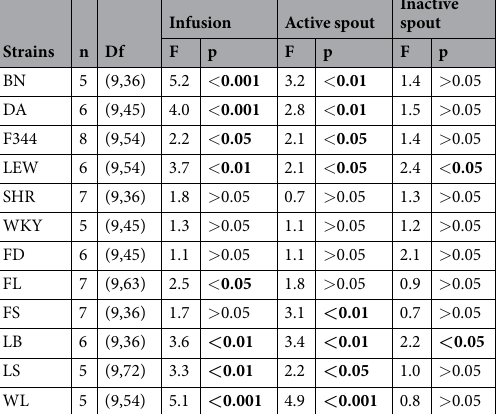
Table 3. Statistical analysis of self-administration data: IIb. Session effect, 30 μ g/kg/inf nicotine.